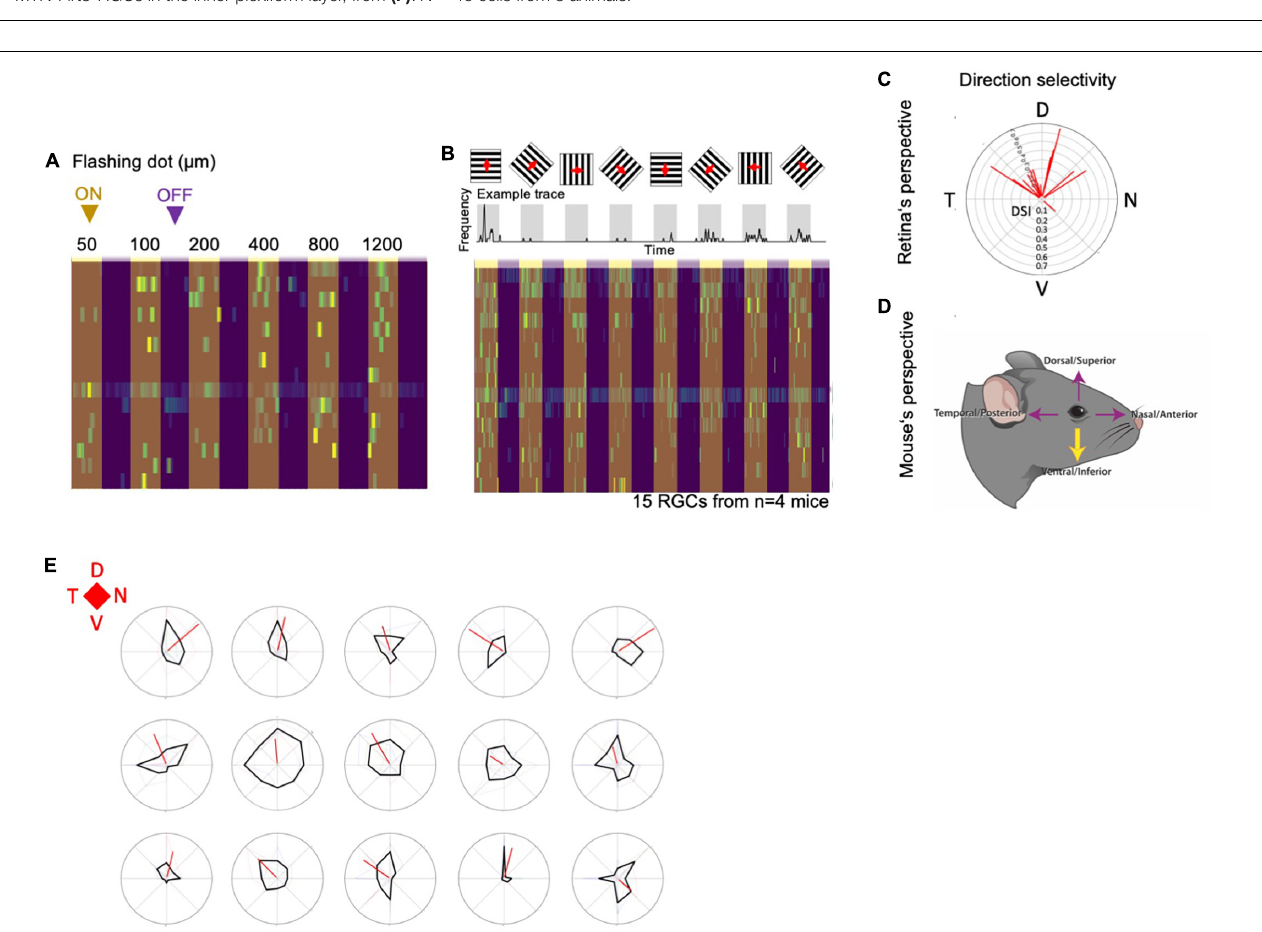
FIGURE 5 | MTN-projecting Flrt3-RGCs. The right panel shows the average normalized stratification pattern of Calbindin (orange), mono- (green, n = 16 cells from 3 animals, 26%) and bistratified MTN-projecting Flrt3-RGCs (magenta, n = 46 cells from 3 animals, 74%). (G) Immunostaining for CART, Calbindin and Parvalbumin in a retinal sections of MTN injected mice from (A) . Tomato signal (magenta) shows MTN-projecting Flrt3-RGCs. (H) Fraction (%) of MTN-projecting Flrt3-RGCs positive for CART, Calbindin and Parvalbumin. N = 60–66 ROIs for each marker from 3 retinas. (I) Normalized stratification patterns of mono- (green) and bistratified (red) MTN-Flrt3-RGCs in the inner plexiform layer, from (F) . N = 46 cells from 3 animals.